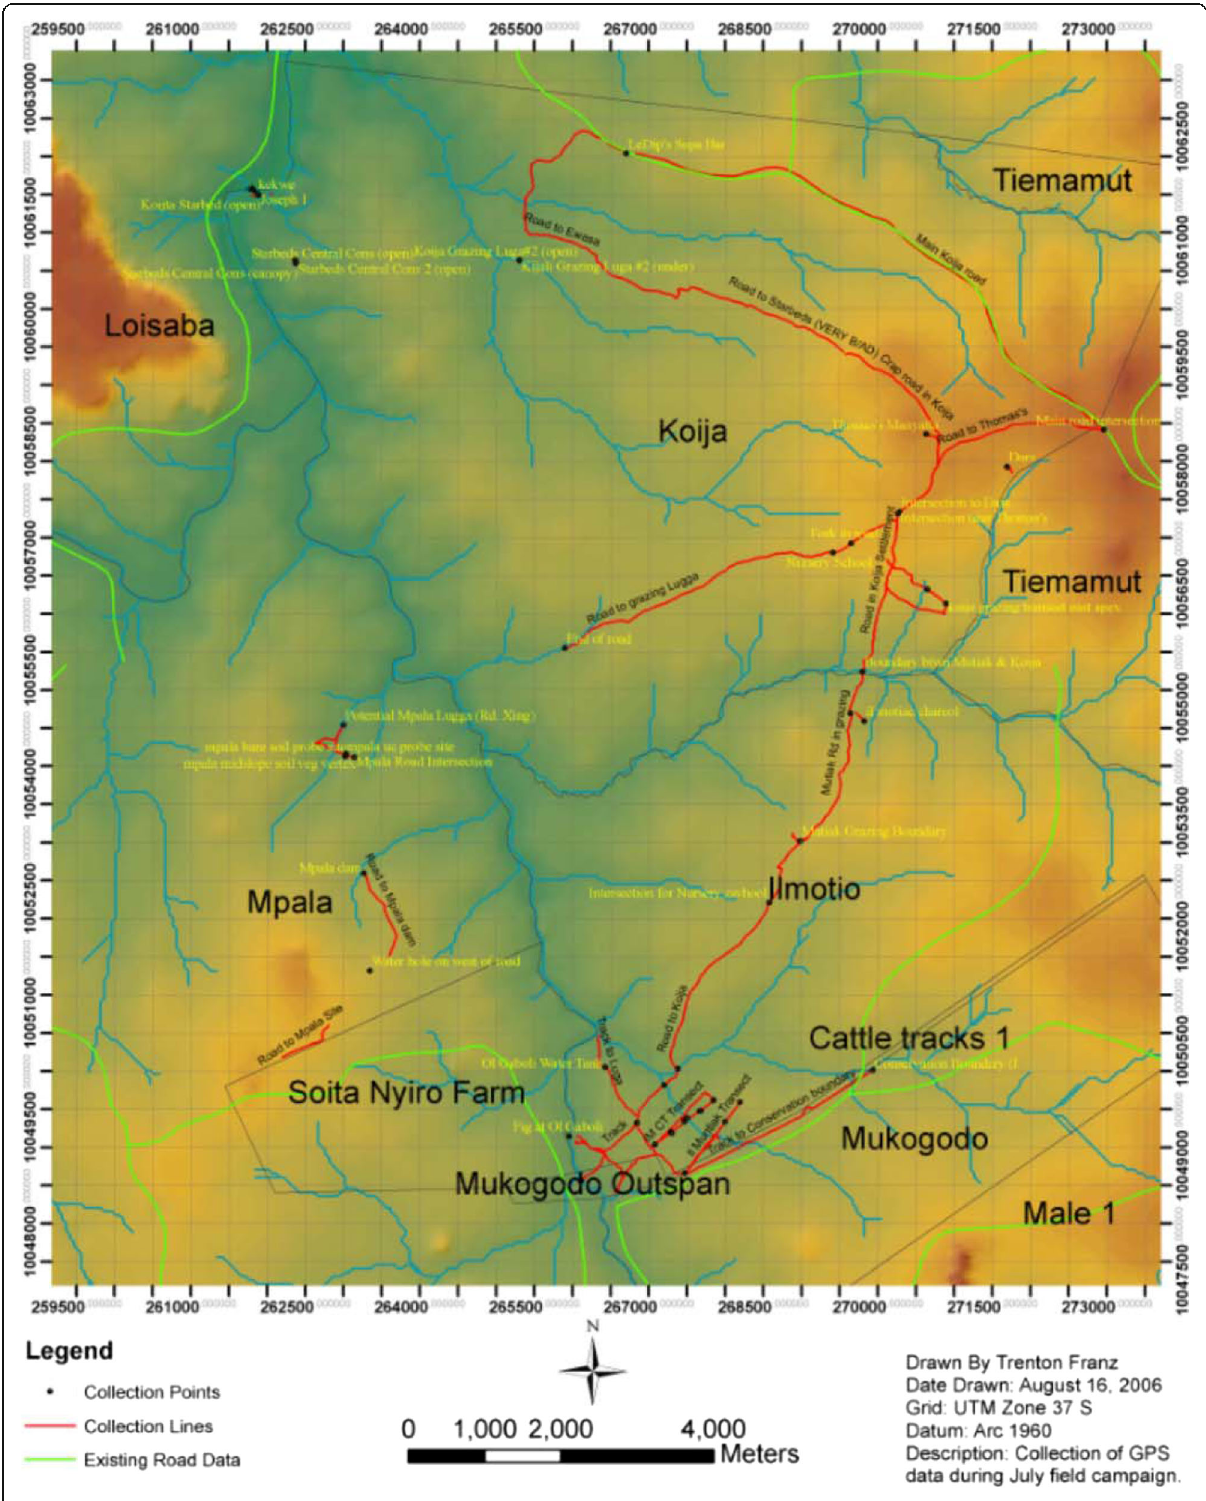
Figure 2 Detailed map of the study area. Research was carried out in the Ilmotiok and Tiamamut group ranches. Trenton Franz generated this map in collaboration with the Ewaso Water Project in